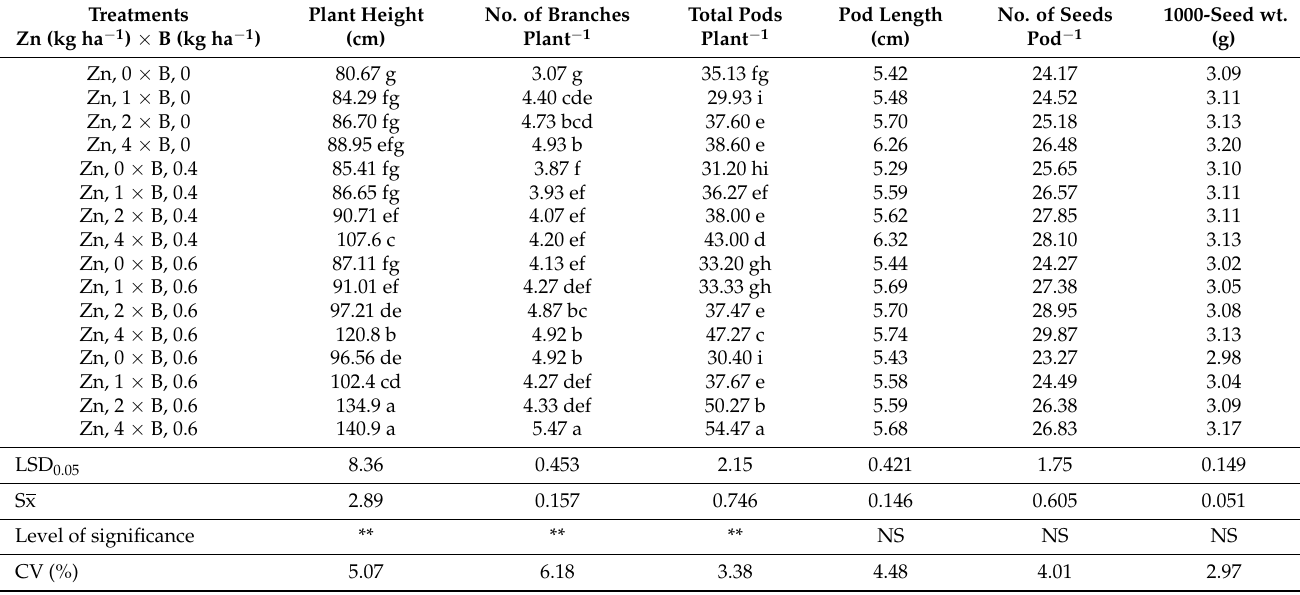
Table 1. Zn and B’s interaction effects on mustard yield characteristics (cv. BARI